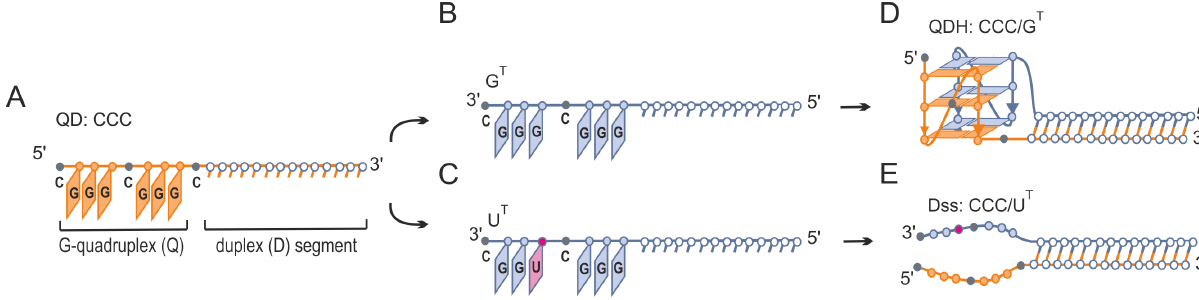
Figure 1. Schematic presentation of the recognition of G T and U T targets by the CCC oligonucleotide. CCC oligonucleotide ( A ) and target sequence with two GGG-tracts, G T ( B ) forms a quadruplex–duplex structural hybrid (QDH) ( D ). CCC oligonucleotide hybridized to the U T target ( C ) forms a duplex with long dangling ends (Dss) ( E ).